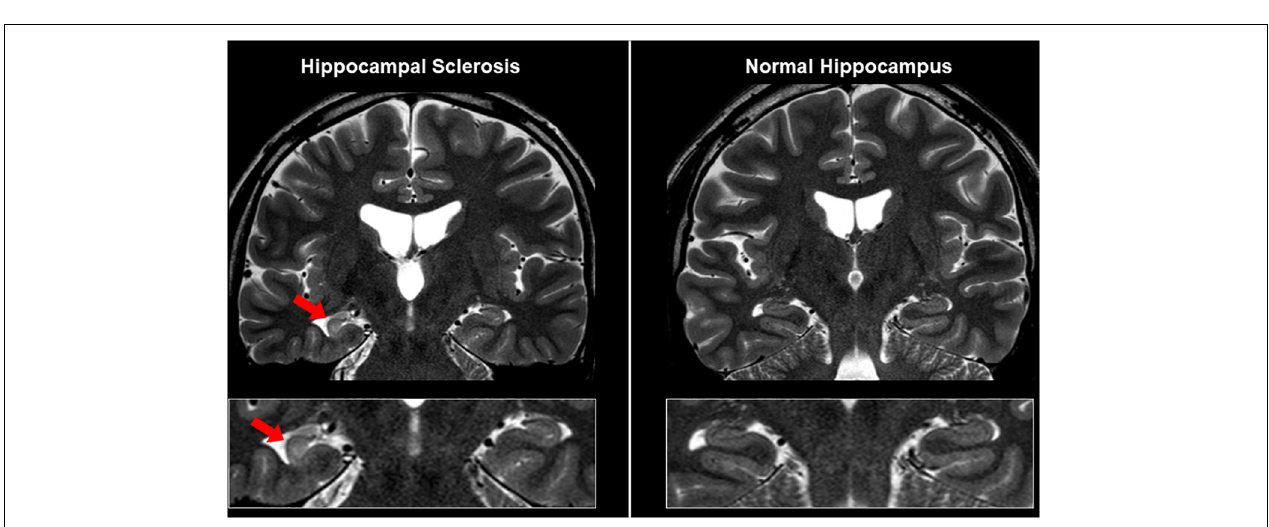
FIGURE 4 | MRI findings in a case with unilateral hippocampal sclerosis (left). The affected hippocampus showed hippocampal atrophy and T2 hyperintensity, and thinning and blurring of the molecular layer, compared with the contralateral side or normal case (right).